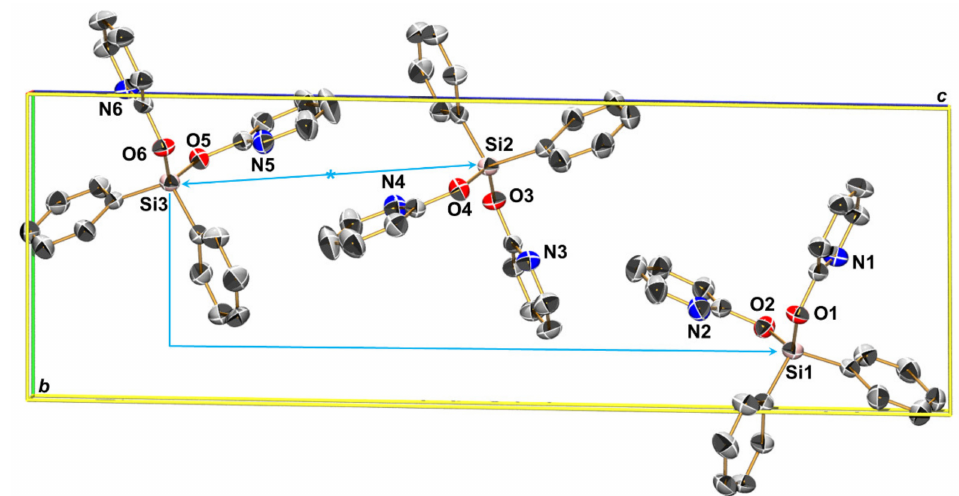
Figure 10. Unit cell packing (view along the a axis) of the three independent molecules of the asymmetric unit of 3a (thermal displacement ellipsoids are drawn at the 50% probability level, selected atoms are labeled, H atoms and disorder parts are omitted for clarity). The light blue arrows indicate pseudo-symmetry relations: whereas molecules 3 and 2 are roughly related to one another by a local center of inversion, the relation between molecules 3 and 1 indicates a local b -glide symmetry (with respect to this unit cell